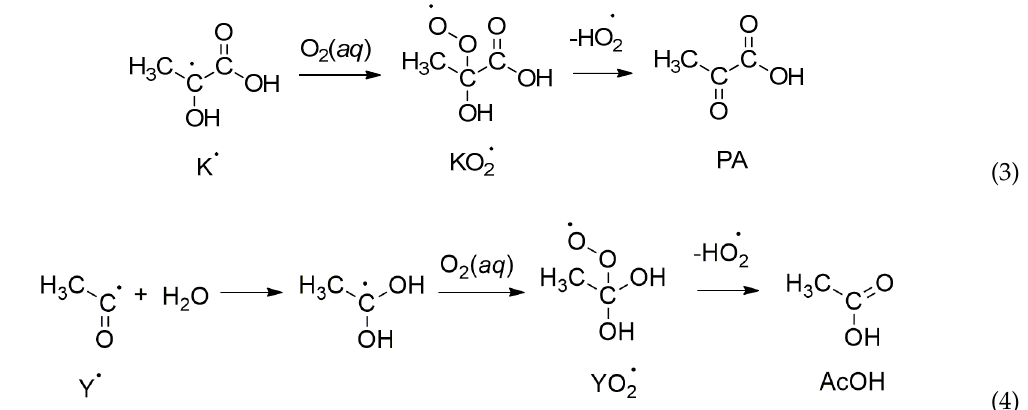
4 of 12 Figure 2. Rate of dissolved oxygen decay ( (cid:1844) (cid:2879)(cid:2899) (cid:3118) ((cid:3028)(cid:3044)) ) at variable initial concentration of PA ([PA] 0 ) during irradiation of solutions at pH 1.0 and 25 °C under continuous air sparging at a flow rate of 30.0 mL min − 1 . The absorbed photon rates are provided in Figure 1. The presented reaction rates are multiplied by − 1. The integration of Equation (1) yields the solution that perfectly describes the concentration of dissolved O 2 vs time ( t ):